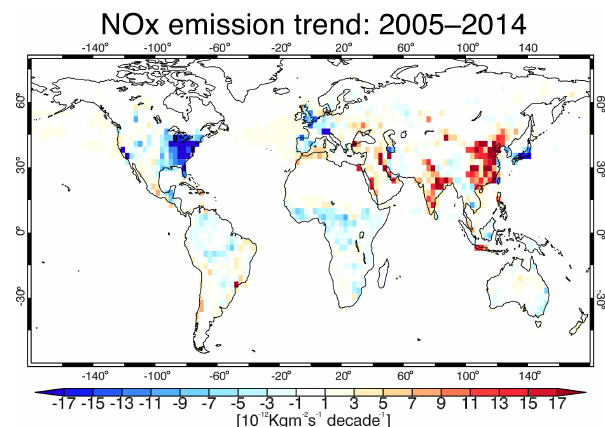
Figure 6. Global distribution of linear trend of the a posteriori sur- face NO x emissions (in 10 − 12 kgm − 2 s − 1 per decade) for the pe- riod 2005–2014. The red (blue) colour indicates positive (negative)